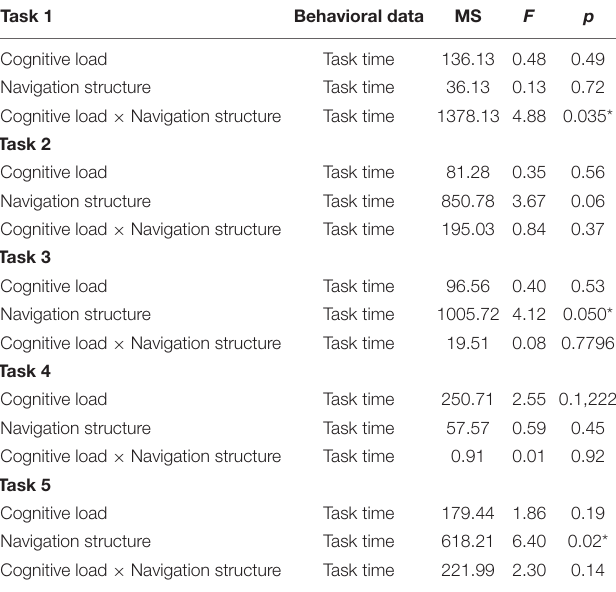
TABLE 5 | Mixed ANOVAs results of task